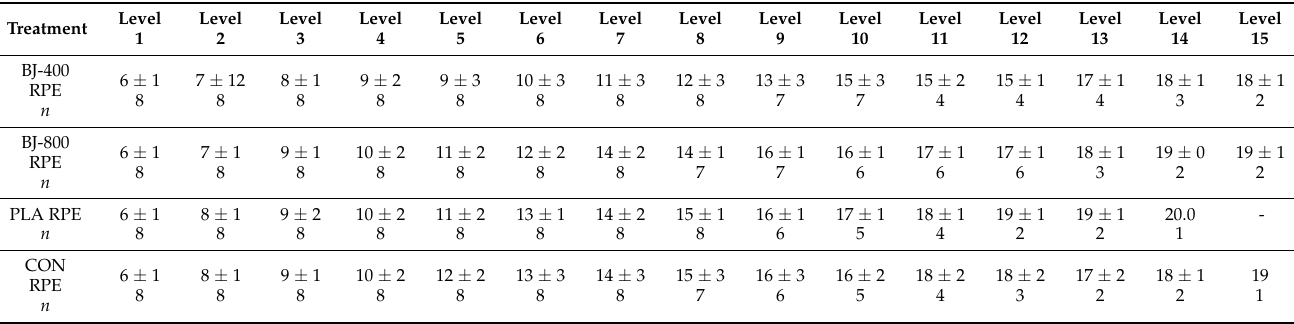
Table 4. Rating of perceived exertion (RPE) in each level of the Progressive Specific Taekwondo Test and the number of participants reaching the level.